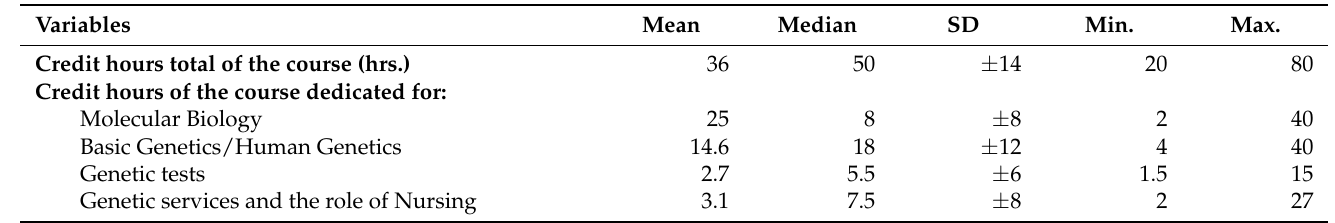
Table 5. Credit hours of the genetics and/or genomics course and the adopted teaching-learning strategies and teaching